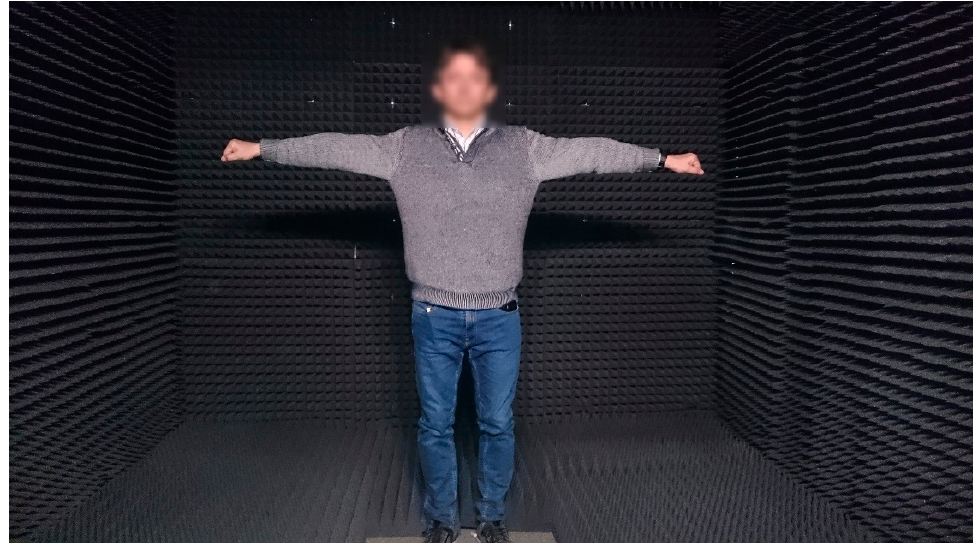
Figure 13. Example of a person under testing.